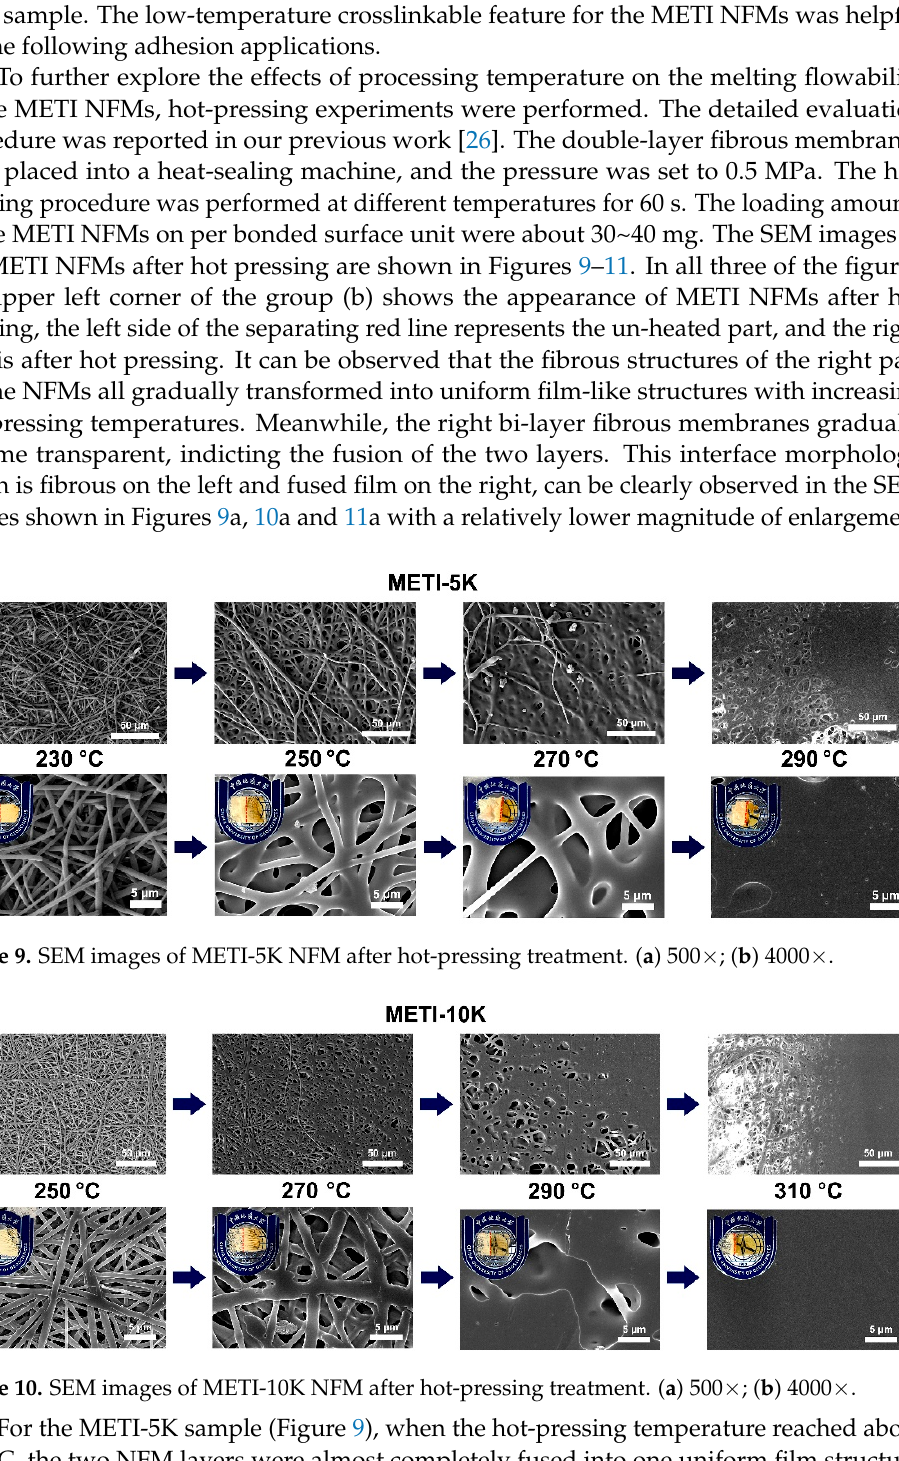
Figure 8. Rheological curves of three molecular weight resins: ( a ) METI; ( b ) METI and PETI.